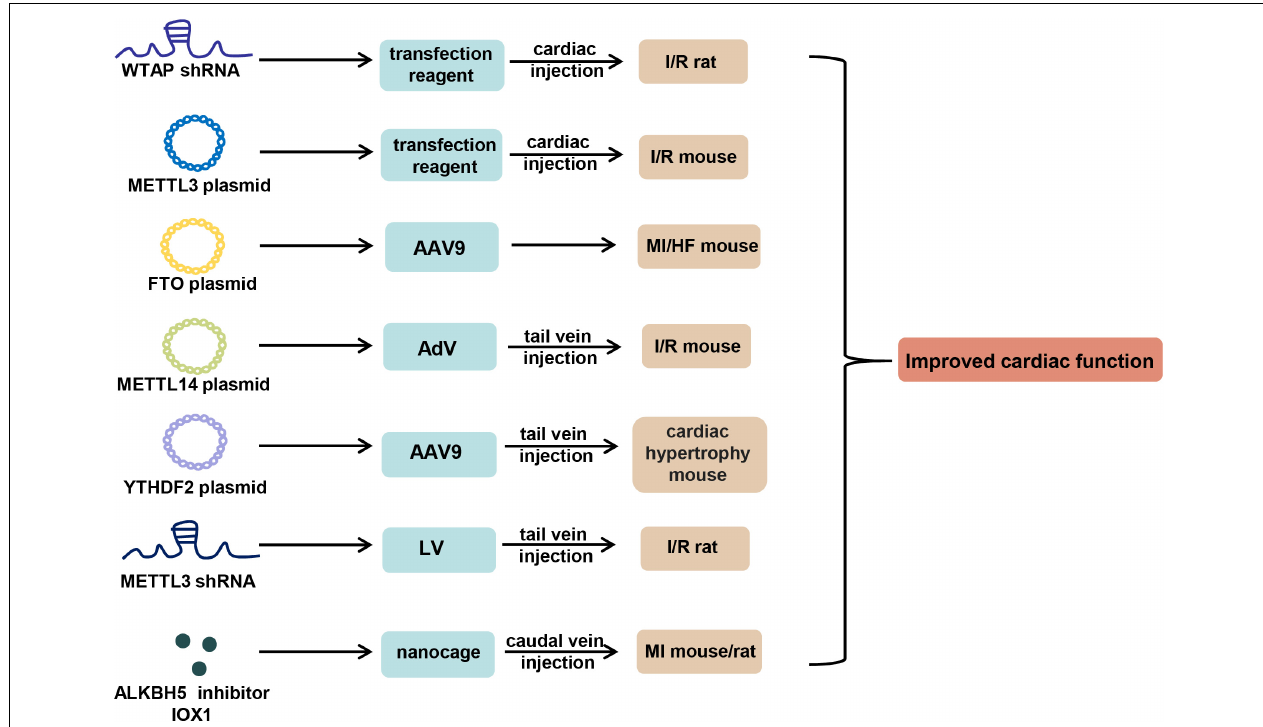
FIGURE 2 | m6A-based therapy for cardiovascular diseases. shRNA of WTAP and METTL3, overexpression plasmid of METTL3, METTL14, FTO, and YTHDF2, and ALKBH5 inhibitor IOX1 can be used to improve cardiac function in mouse or rat models of CVDs by virtue of in vivo transfection reagent, AAV9, AdV, LV, and nanocage through the approach of cardiac or tail vein injection. AAV9, adeno-associated virus serotype 9; AdV, adenovirus; LV, lentivirus.